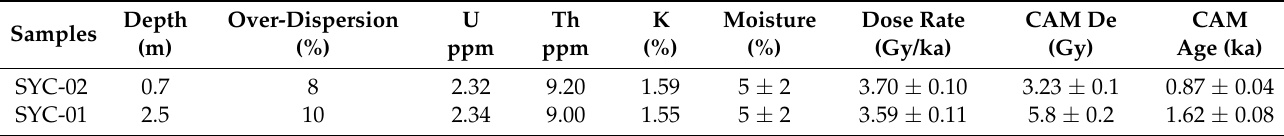
Table 1. K-feldspar pIRIR dating results for